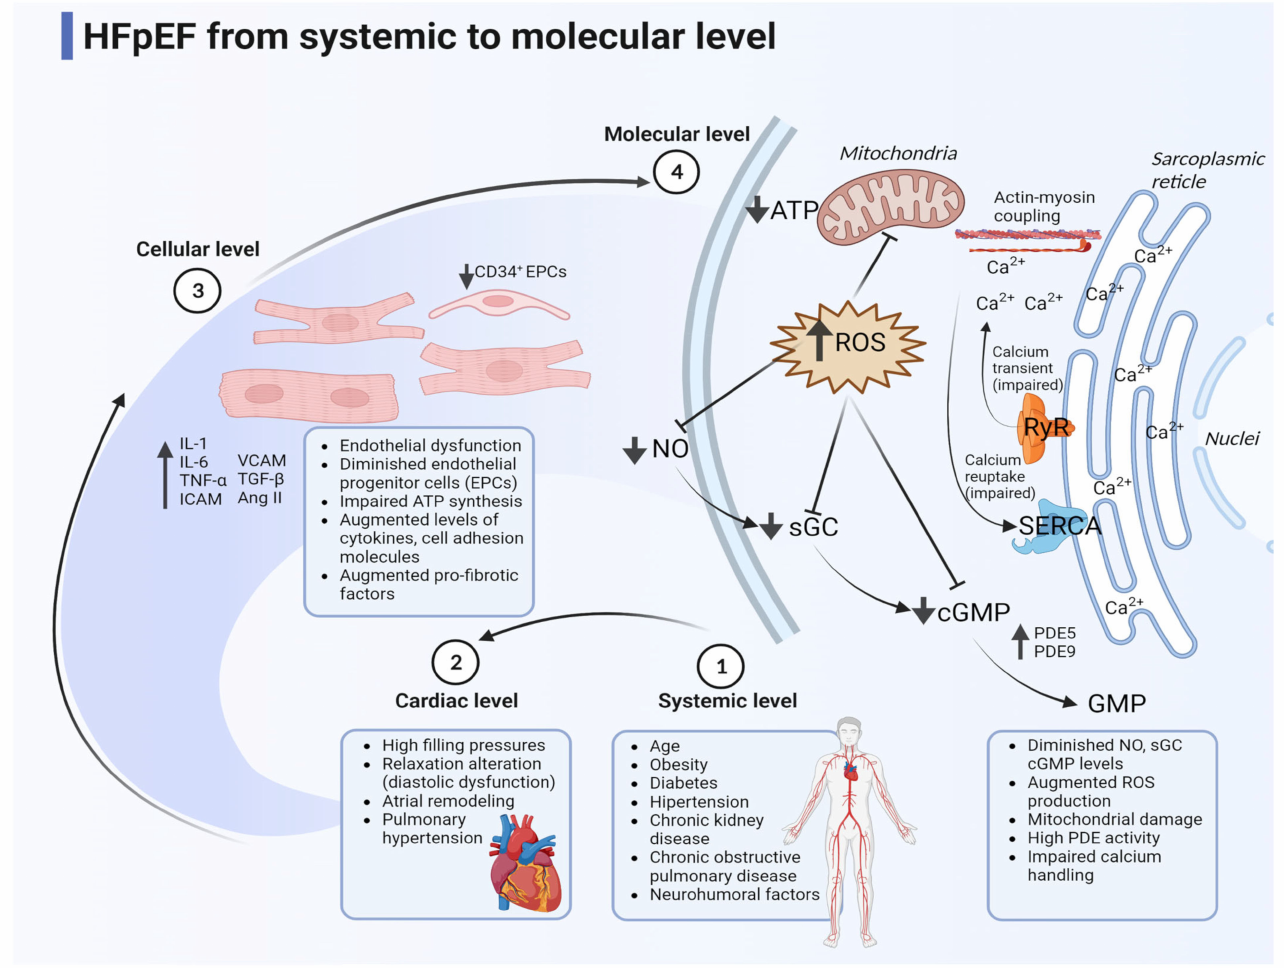
Figure 1. Key mechanisms in HFpEF. Various pathophysiology targets for new therapies use in different pre-clinical and clinical ongoing trials from systemic to the molecular level (IL = inter- leukin; TNF = tumor necrosis factor; ICAM = intercellular adhesion molecule; VCAM = vascular cell adhesion molecule; TGF = transforming growth factor; AngII = angiotensin II; NO = nitric oxide; sGC = soluble guanylyl cyclase; cGMP = cyclic guanosine monophosphate; ROS = reactive oxy- gen species; PDE = phosphodiesterase; ATP = adenosine triphosphate; RyR = ryanodine receptor; SERCA = sarco/endoplasmic reticulum Ca 2+ -ATPase) (created with Biorender). At the molecular level, chronic inflammation is a leading cause of HFpEF due to